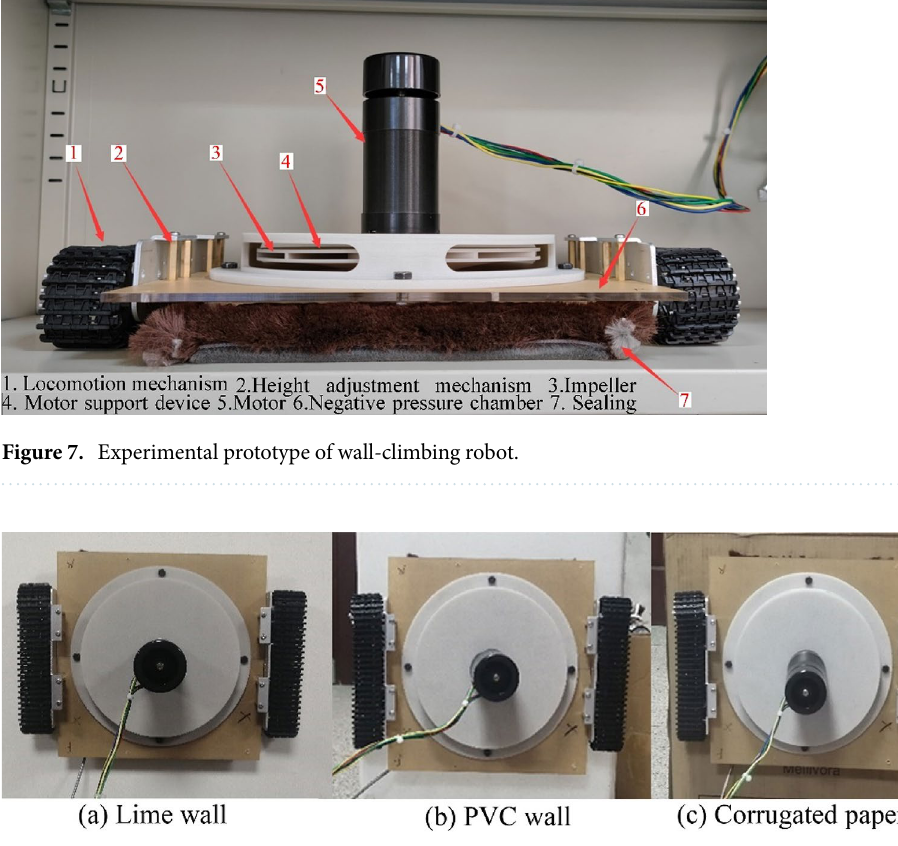
Figure 8. Experiments on different wall